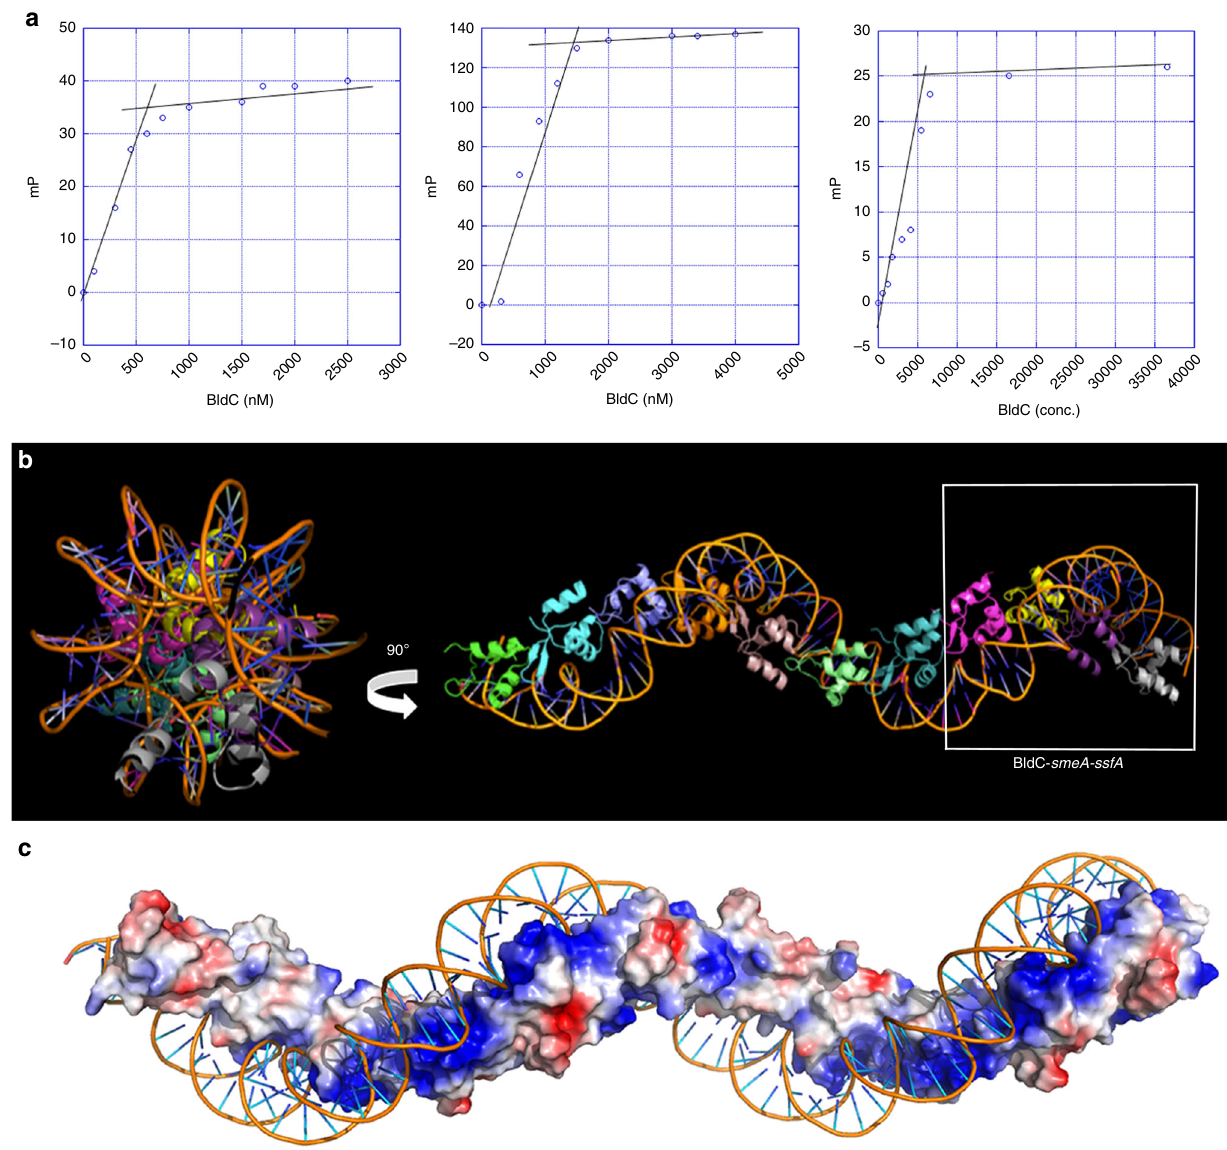
Fig. 5 BldC binds DNA to form extended protein-nucleic acid superstructural fi laments. a FP-based stoichiometry binding experiments performed with fl uoresceinated 22mer opt, 36mer opt (containing 4 binding repeats), and the smeA-ssfA BldC site, each experiment was conducted in technical triplicate with a representative analysis shown for each. For the experiments, DNA was present at a concentration 10-fold above the K d s, which are 20, 20, and 60 nM, respectively. Binding was observed as increasing mPs until saturation, at which the mPs no longer increase. The in fl ection point of each binding isotherm represents the subunit protein concentration at saturation. This occurred at BldC: DNA duplex stoichiometries of 2:1, 4:1, and 4:1, respectively. b Structure of the BldC- smeA-ssfA promoter complex. The DNA packs pseudo-continuously. The unit corresponding to the BldC- smeA-ssfA complex is boxed. Two views are shown. Left is a view looking down the axis of the structure and right shows the view rotated 90°. The structure shows how BldC could bind promoters with longer sites than present in the smeA-ssfA promoter. c Electrostatic representation of the structure with blue and red, representing electropositive and electronegative regions. Notably, the continuous protein superstructure also forms a continuous electropositive stripe that tracks along the